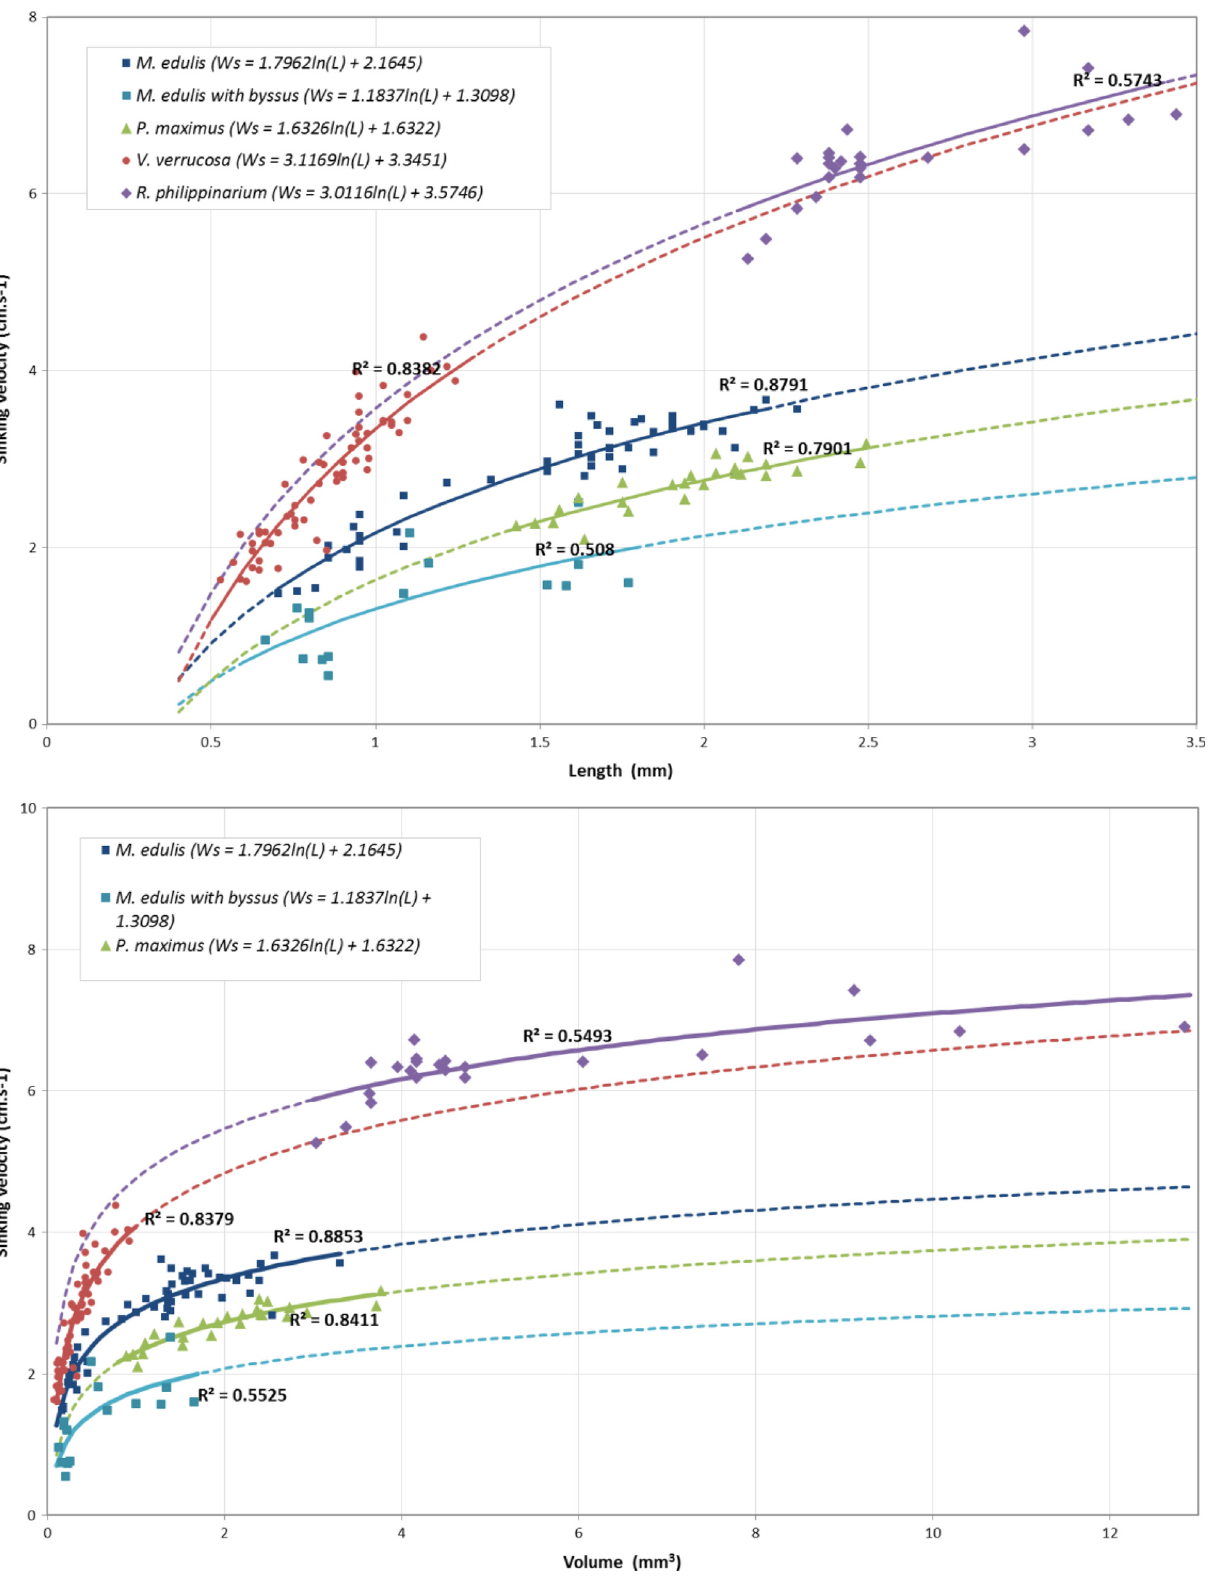
Fig. 1. Relationships between sinking velocity and volume (top graphic) or shell length (bottom graphic) for actives recruits of the four species and mussel recruits producing byssus thread. Lines are logarithmic regression curves ( W s = a (cid:2) ln(Size) þ b ) with their respective coef fi cients of determination ( R 2 ), the solid lines relate to the size range of the individuals studied for each species and the dashed lines correspond to an extension of the regression outside this